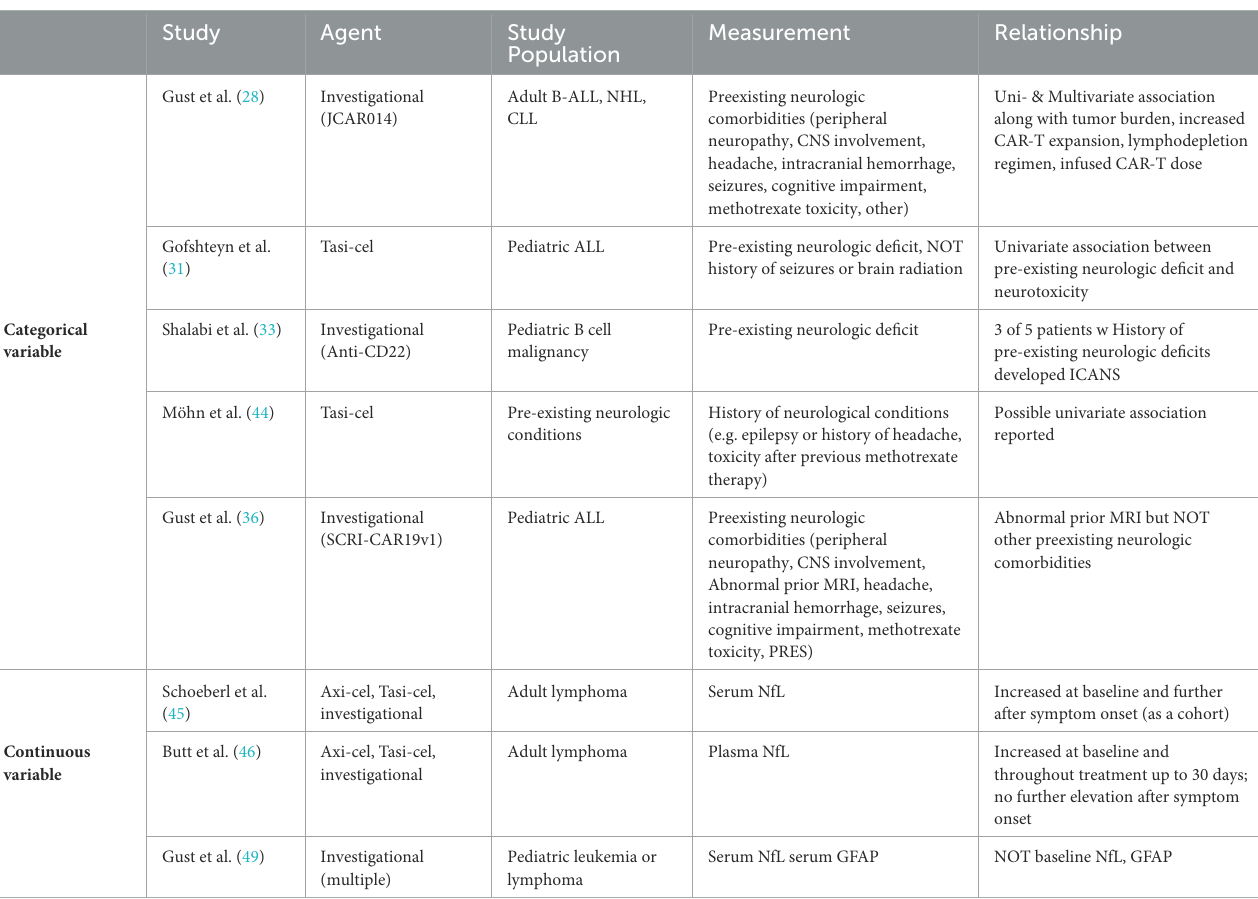
TABLE 4 Summary of studies examining baseline neurologic injury divided by